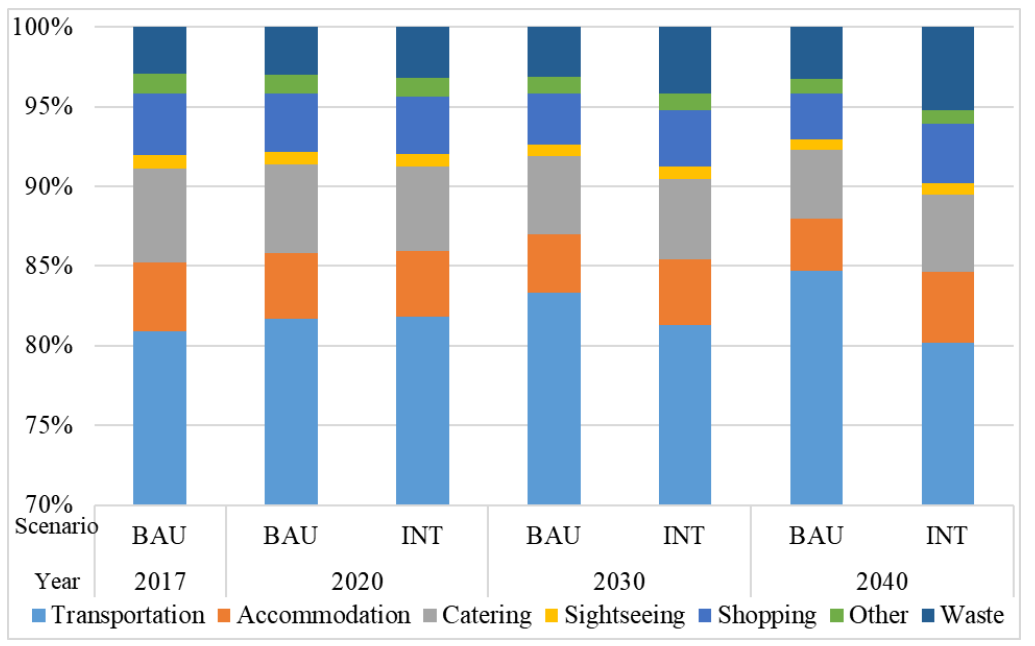
Figure 6. Proportion of GHG emissions by sector under the two scenarios.